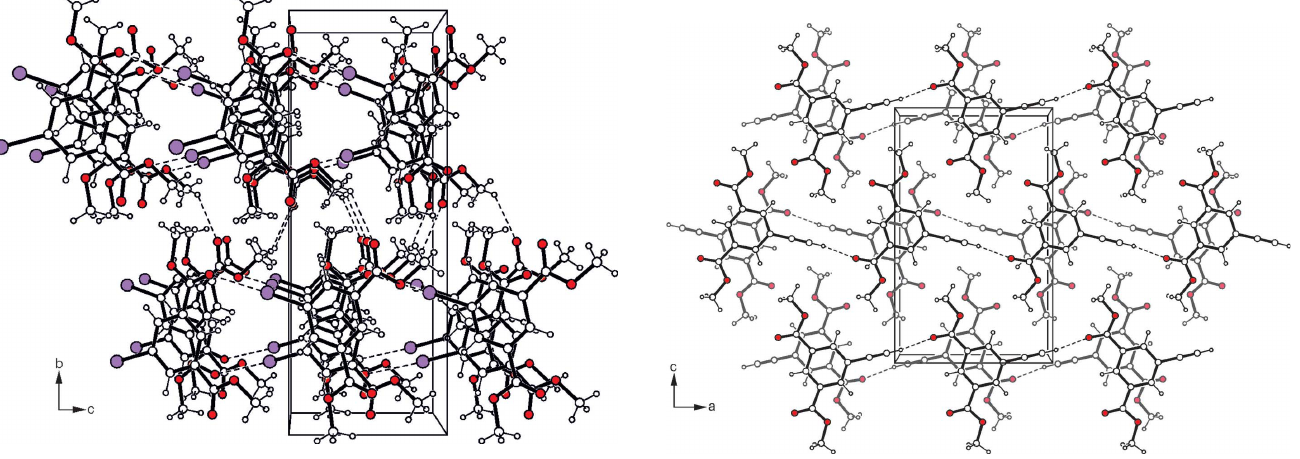
Figure 3 Packing excerpt of compound (II) viewed down the b axis. Dashed lines represent hydrogen-bonding interactions.